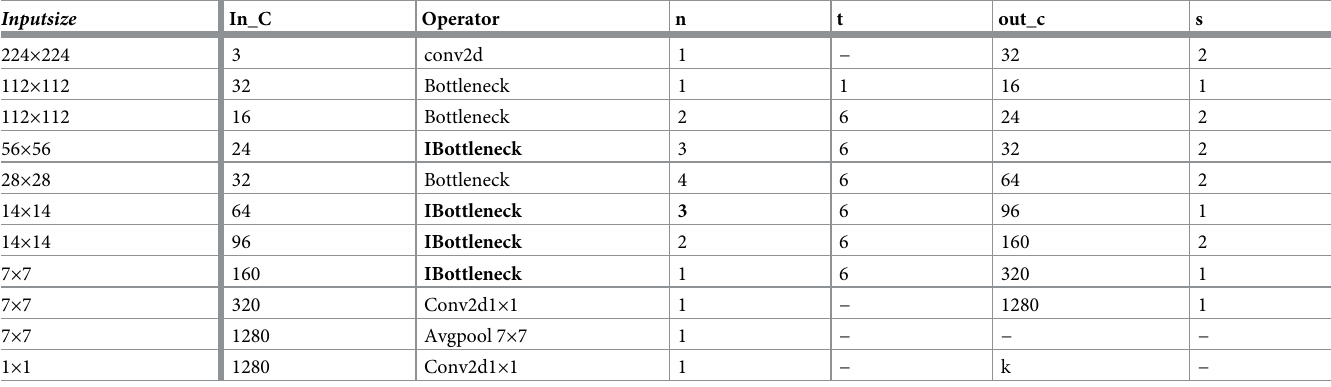
Table 5. The network structure of improved MobileNetV2. Inputsize In_C